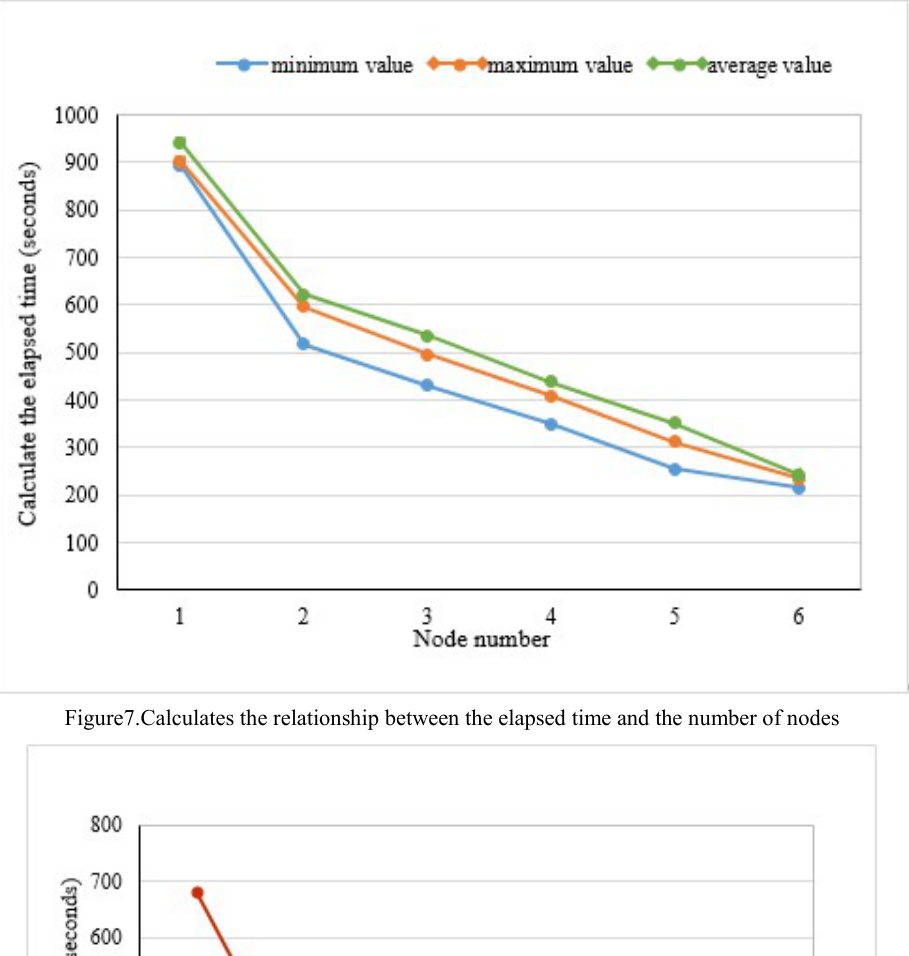
Figure7.Calculates the relationship between the elapsed time and the number of nodes